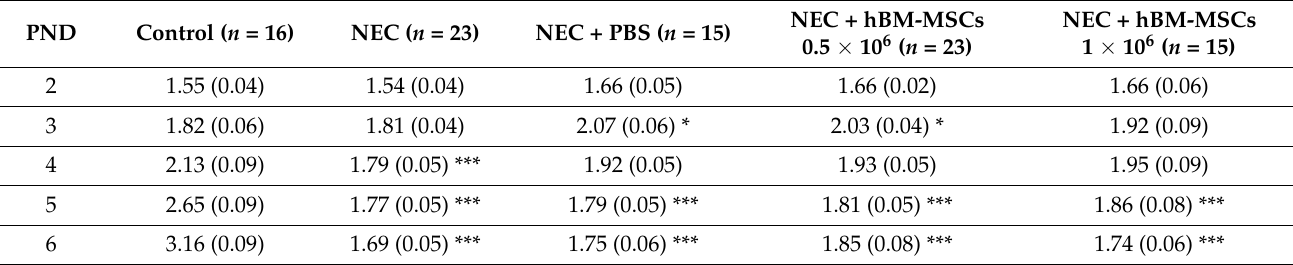
Table 2. Bodyweight changes (g) during experimental procedures.